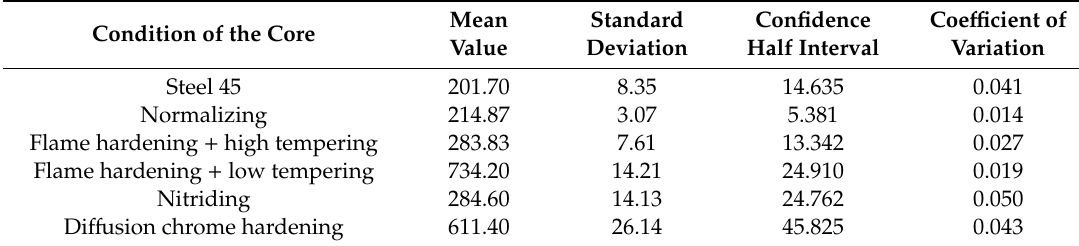
Table 8. HV1 core